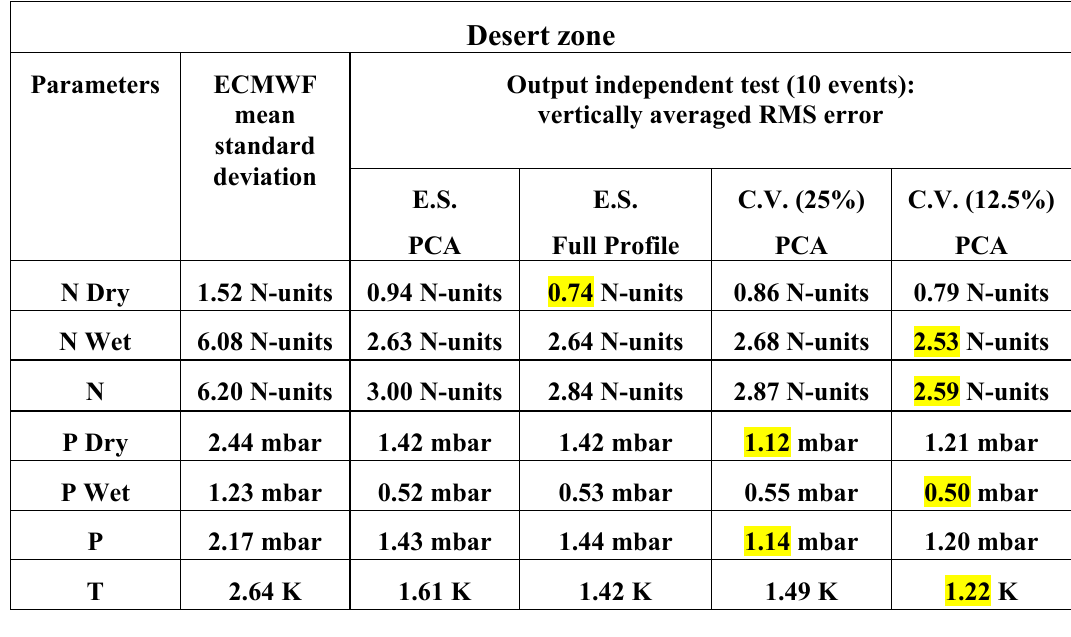
Table 5. Desert zone: mean standard deviation of ECMWF profiles, vertically averaged RMS error of dry refractivity (N Dry), wet refractivity (N Wet), total refractivity (N), dry pressure (P Dry), wet pressure (P Wet), total pressure (P) and temperature (T) profiles obtained by neural network independent test (10 events) using the different